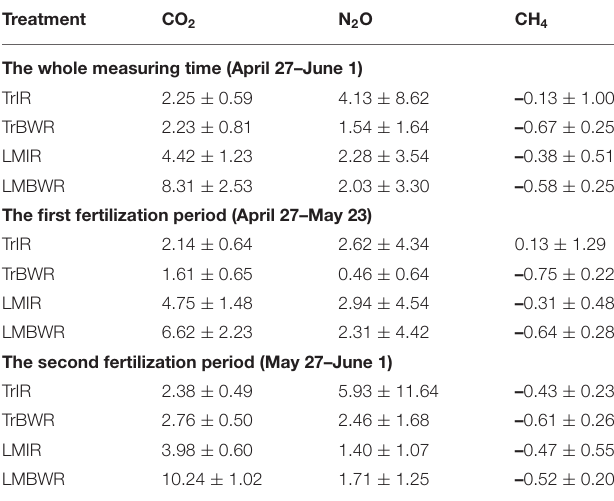
TABLE 5 | Average and standard deviation of trace gas fluxes (CO 2 : µ mol m − 2 s − 1 , N 2 O and CH 4 : µ mol m − 2 hr − 1 ) for four measurements throughout the whole measurement period ( n = 200 for all trace gas species) and both first ( n = 107 for all trace gas species) and second ( n = 93 for all trace gas species) fertilization periods in 2019.